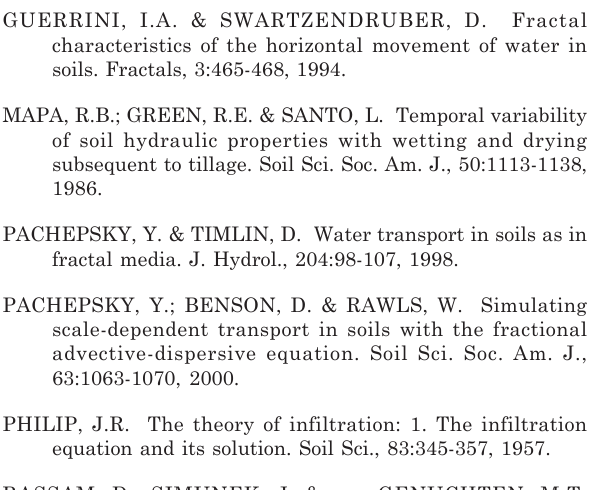
Figure 9. Variation of estimated time exponent ( n ) at each iteration level for clay and loam